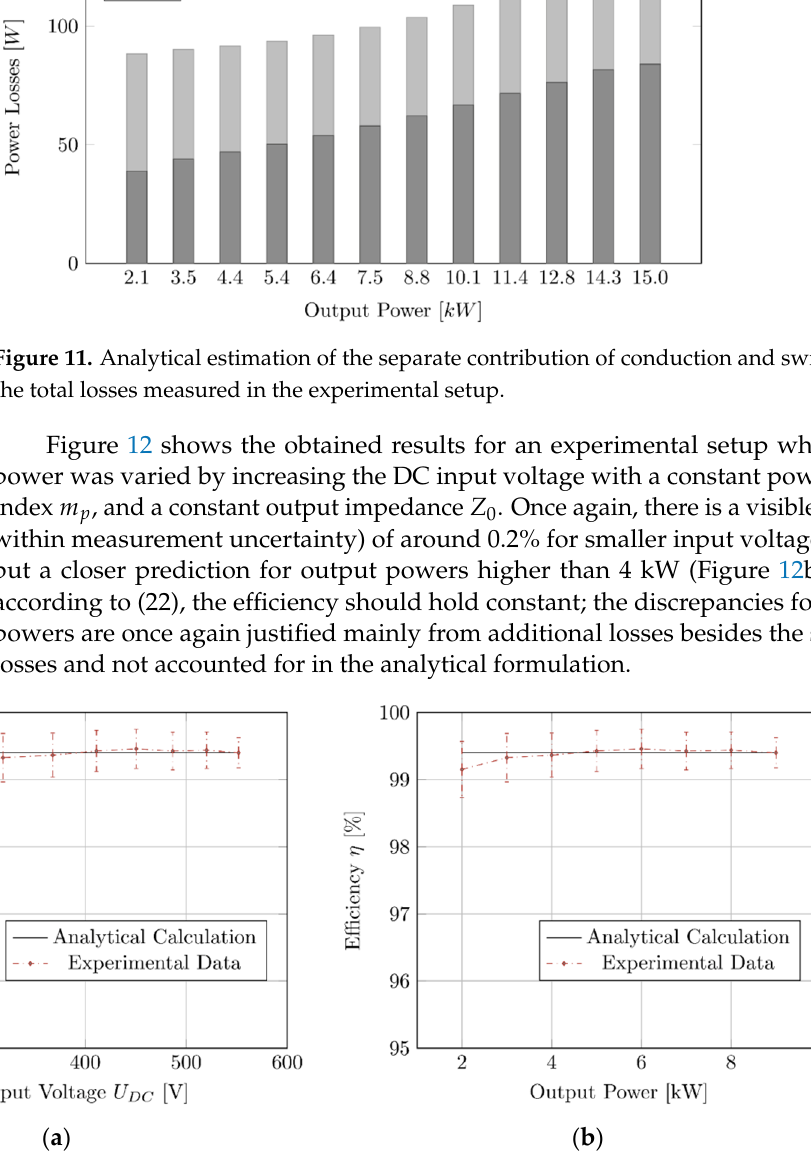
Figure 10. Efficiency vs. Power Modulation Index ( a ) and Output Power ( b ) comparison between experimental results (dashed) and analytical calculation.